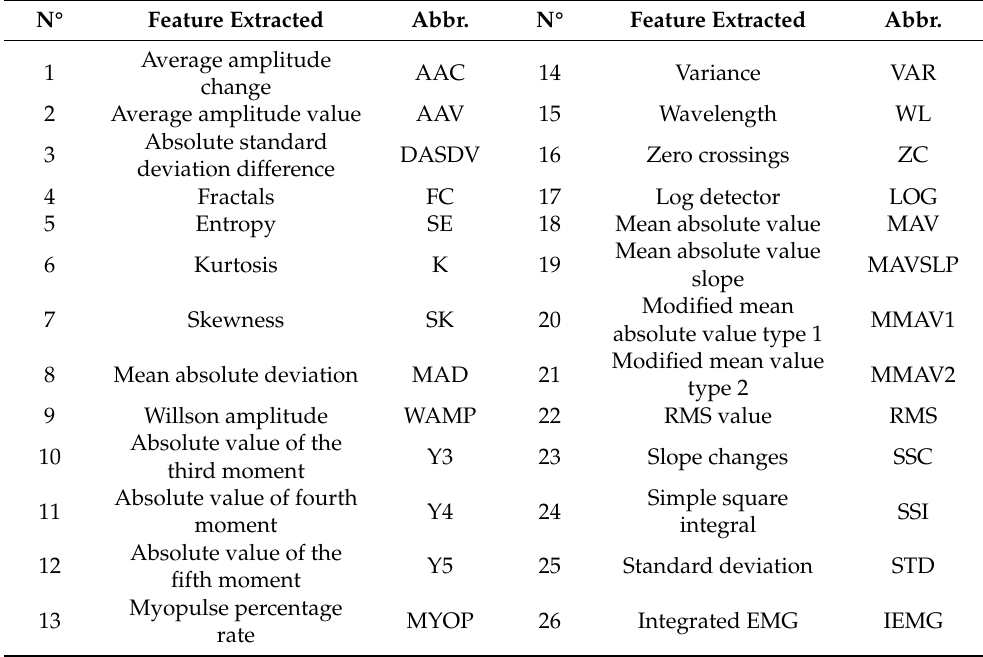
Table 3. The most common time domain indicators in the classification of EMG signals. N° Feature Extracted Abbr. N° Feature Extracted